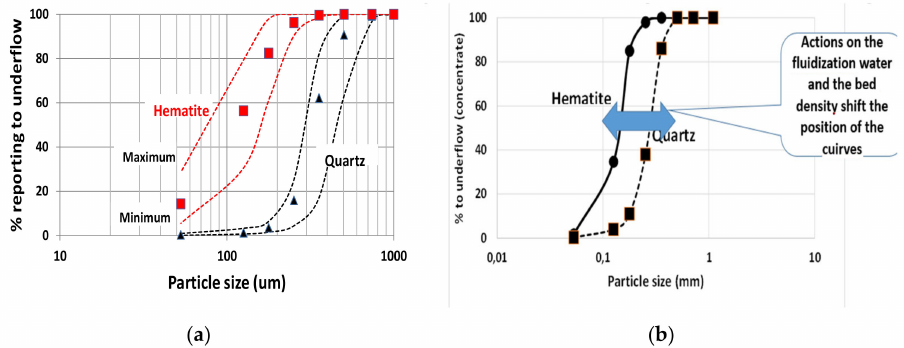
Figure A4. Simplified diagrams of the ( a ) partition curves for hematite and quartz in the primary Hcs of Figure A3 and ( b ) the position of the partition curves can be changed by acting on the fluidization water and thus on the bed density. Symbols are the average values of 7 sampling campaigns; dashed lines give the extreme values